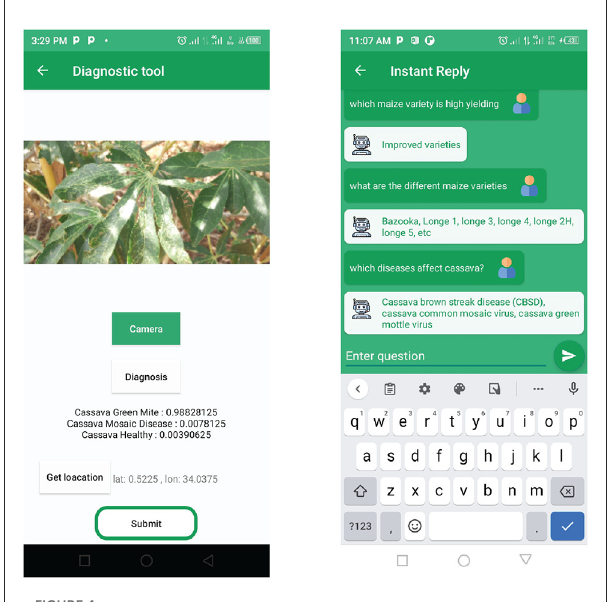
(LSTM) layer with 256 cells, an attention layer, dropout (rate = 0.3), and a Long Short Term Memory decoder layer with